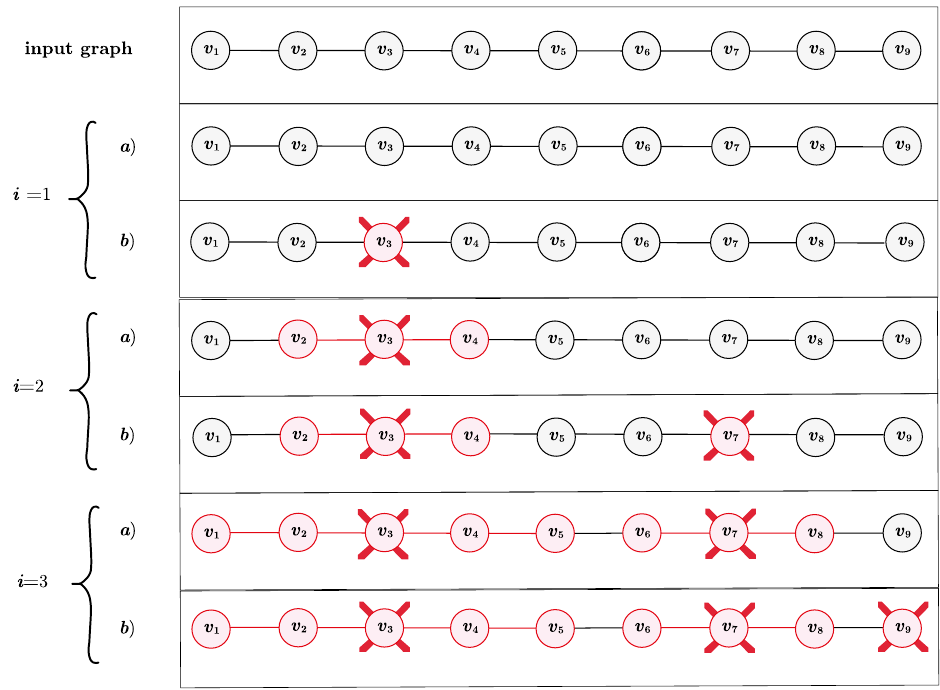
Figure 1. An optimal burning sequence for a nine vertices path is ( v 3 , v 7 , v 9 ) . The burning process of this sequence is depicted by each i ∈ { 1,2,3 } with its corresponding steps a and b. Notice that vertex v 3 burns all vertices in N 2 [ v 3 ] , vertex v 7 burns all vertices in N 1 [ v 7 ] , and vertex v 9 burns all vertices in N 0 [ v 9 ]